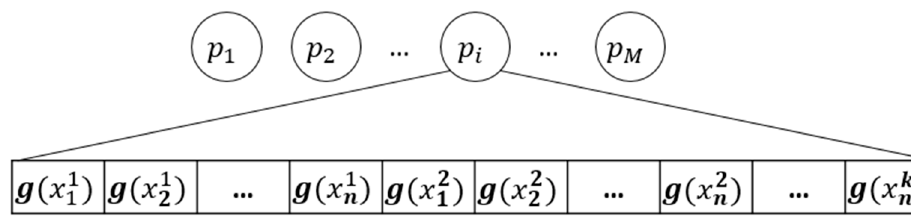
Figure 6. Encoding of particles.